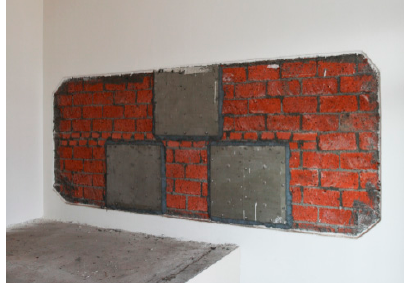
Figure 13. Phase change heat storage device.